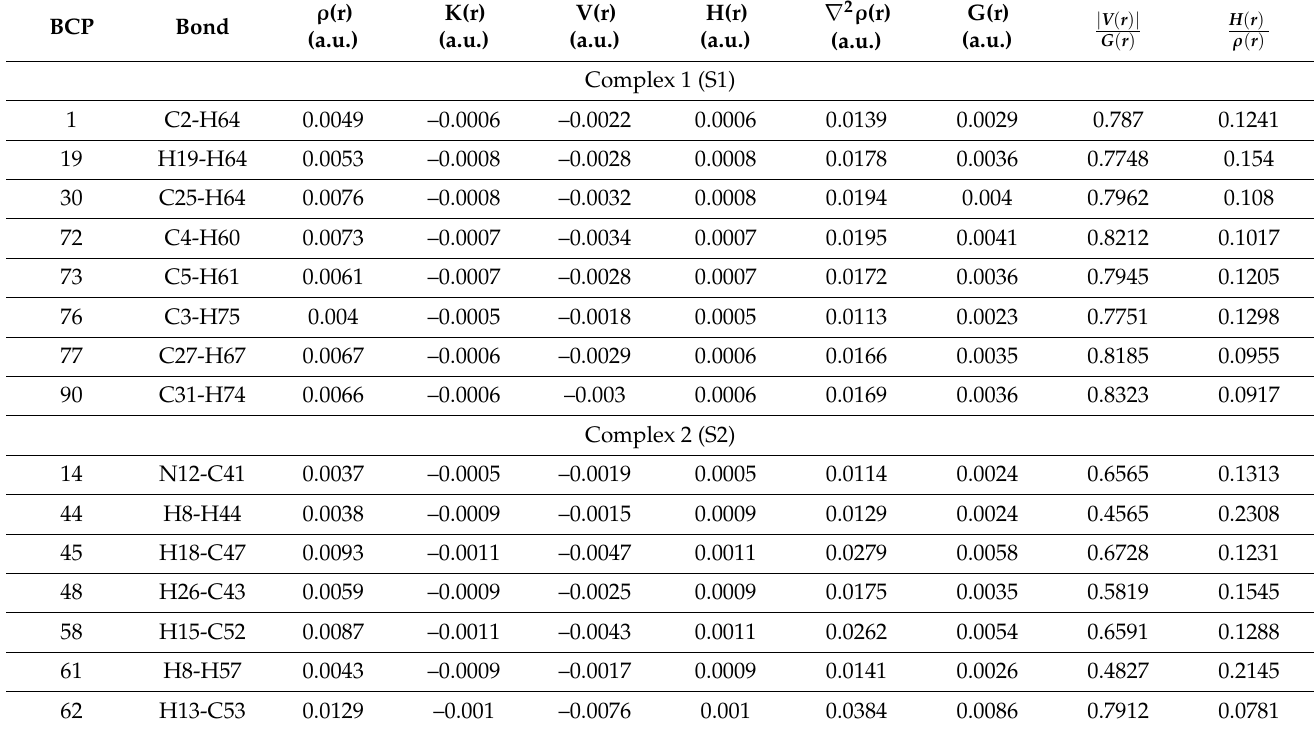
Table 6. AIM parameters of chosen H-bonds at bond critical points (BCPs) for the interaction between procainamide and tetraphenyl borate